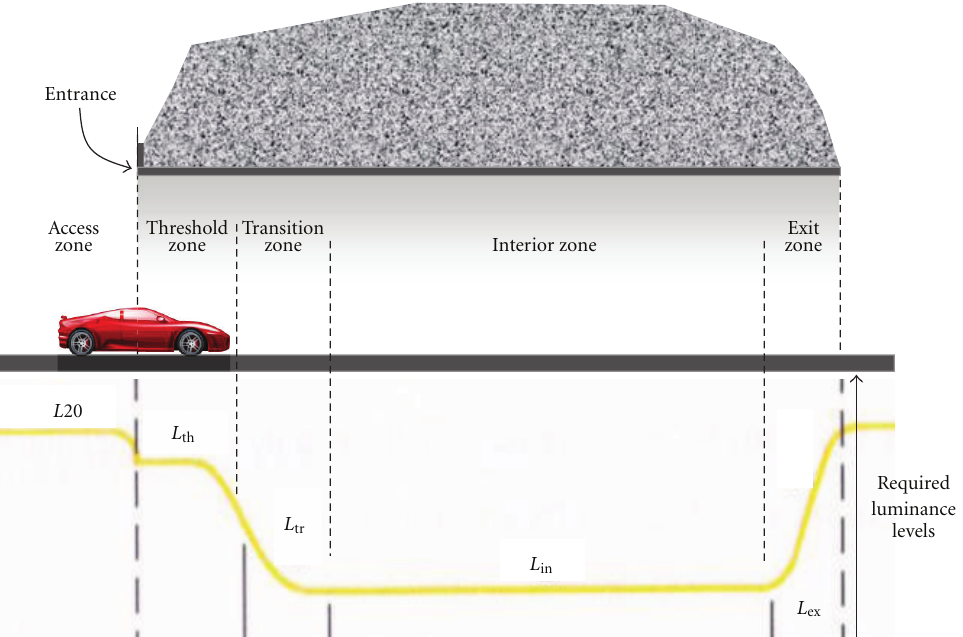
Figure 1: Tunnel zones and luminance values.